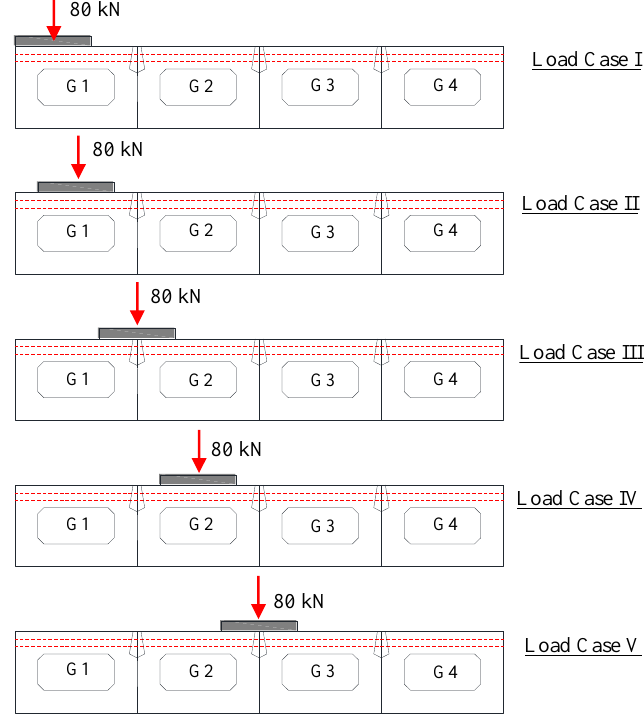
Figure 13. Schematic for different wheel load locations.